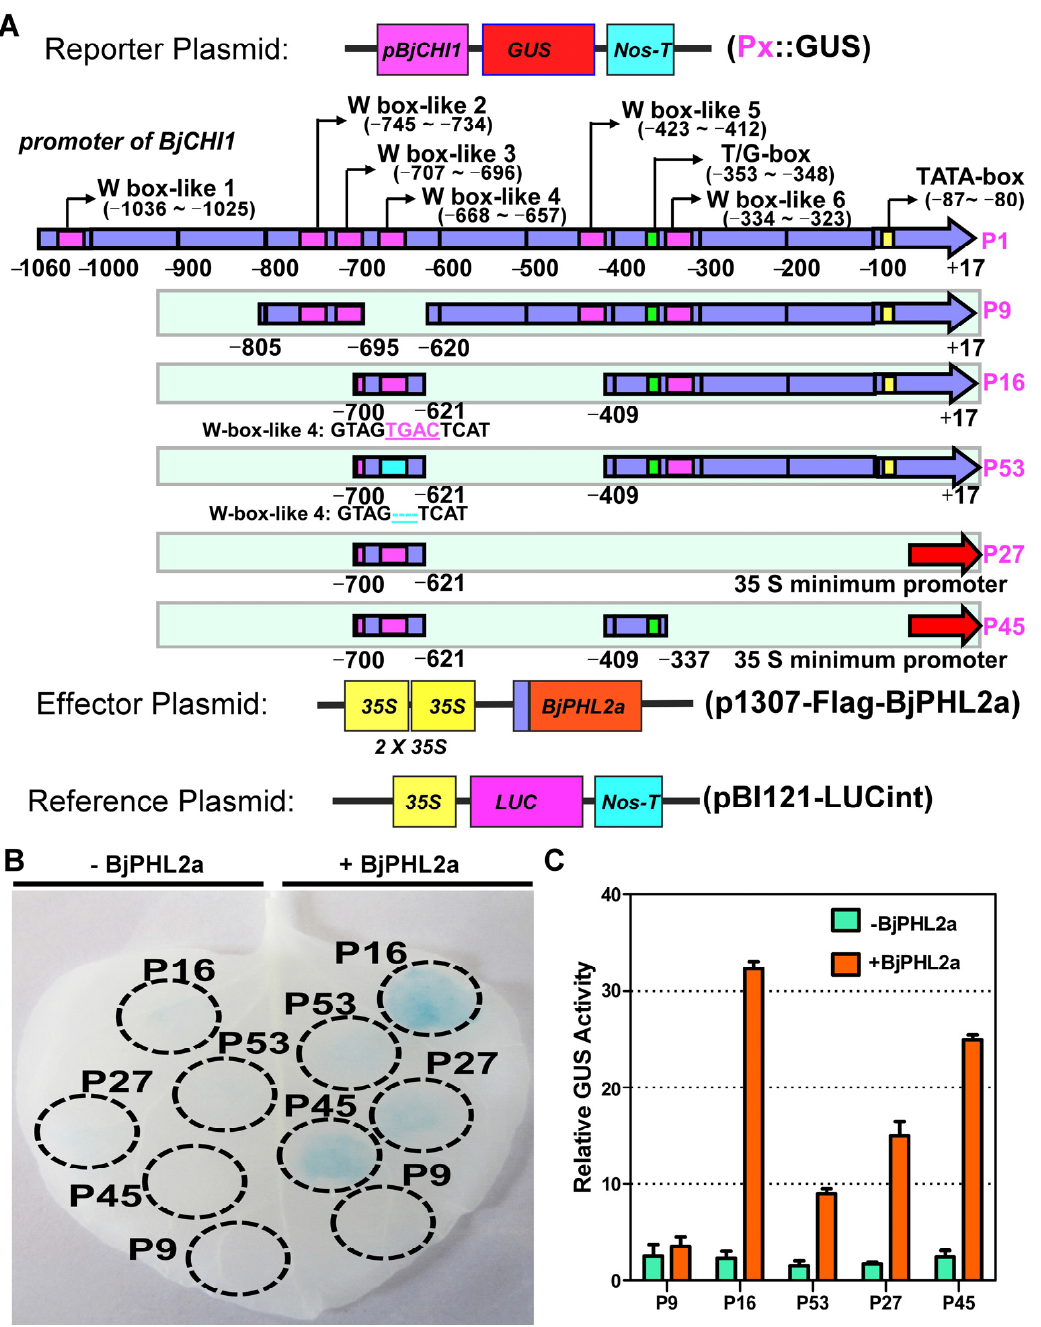
Figure 10. BjPHL2a binds to the Wbl-4 element in vivo . ( A ) Schematic diagram of the reporter and the effector constructs used in co-transfection experiments. For the reporter construct, the deletion- and mutation-derivatives of the BjCHI1 promoter (P9, P16, P27, P45, and P53) were fused with GUS. For the effector construct, 2 × 35S is a tandem repeat of the cauliflower mosaic virus (CaMV) 35S promoter that is used to express BjPHL2a in tobacco leaves. ( B ) Transactivation activity of the reporter constructs based on BjPHL2a expression. Tobacco leaves co-infiltrated with the indicated constructs were stained with X-Gluc for GUS expression analysis. The infiltration areas are indicated with dashed cycles. ( C ) Quantization of GUS activity for every construct in transiently transformed tobacco leaves. The GUS activity was normalized to LUC activity. Columns show the ratio of GUS activity induced by BjPHL2a to that of no induction. Values represent means ± SD from three replicates.